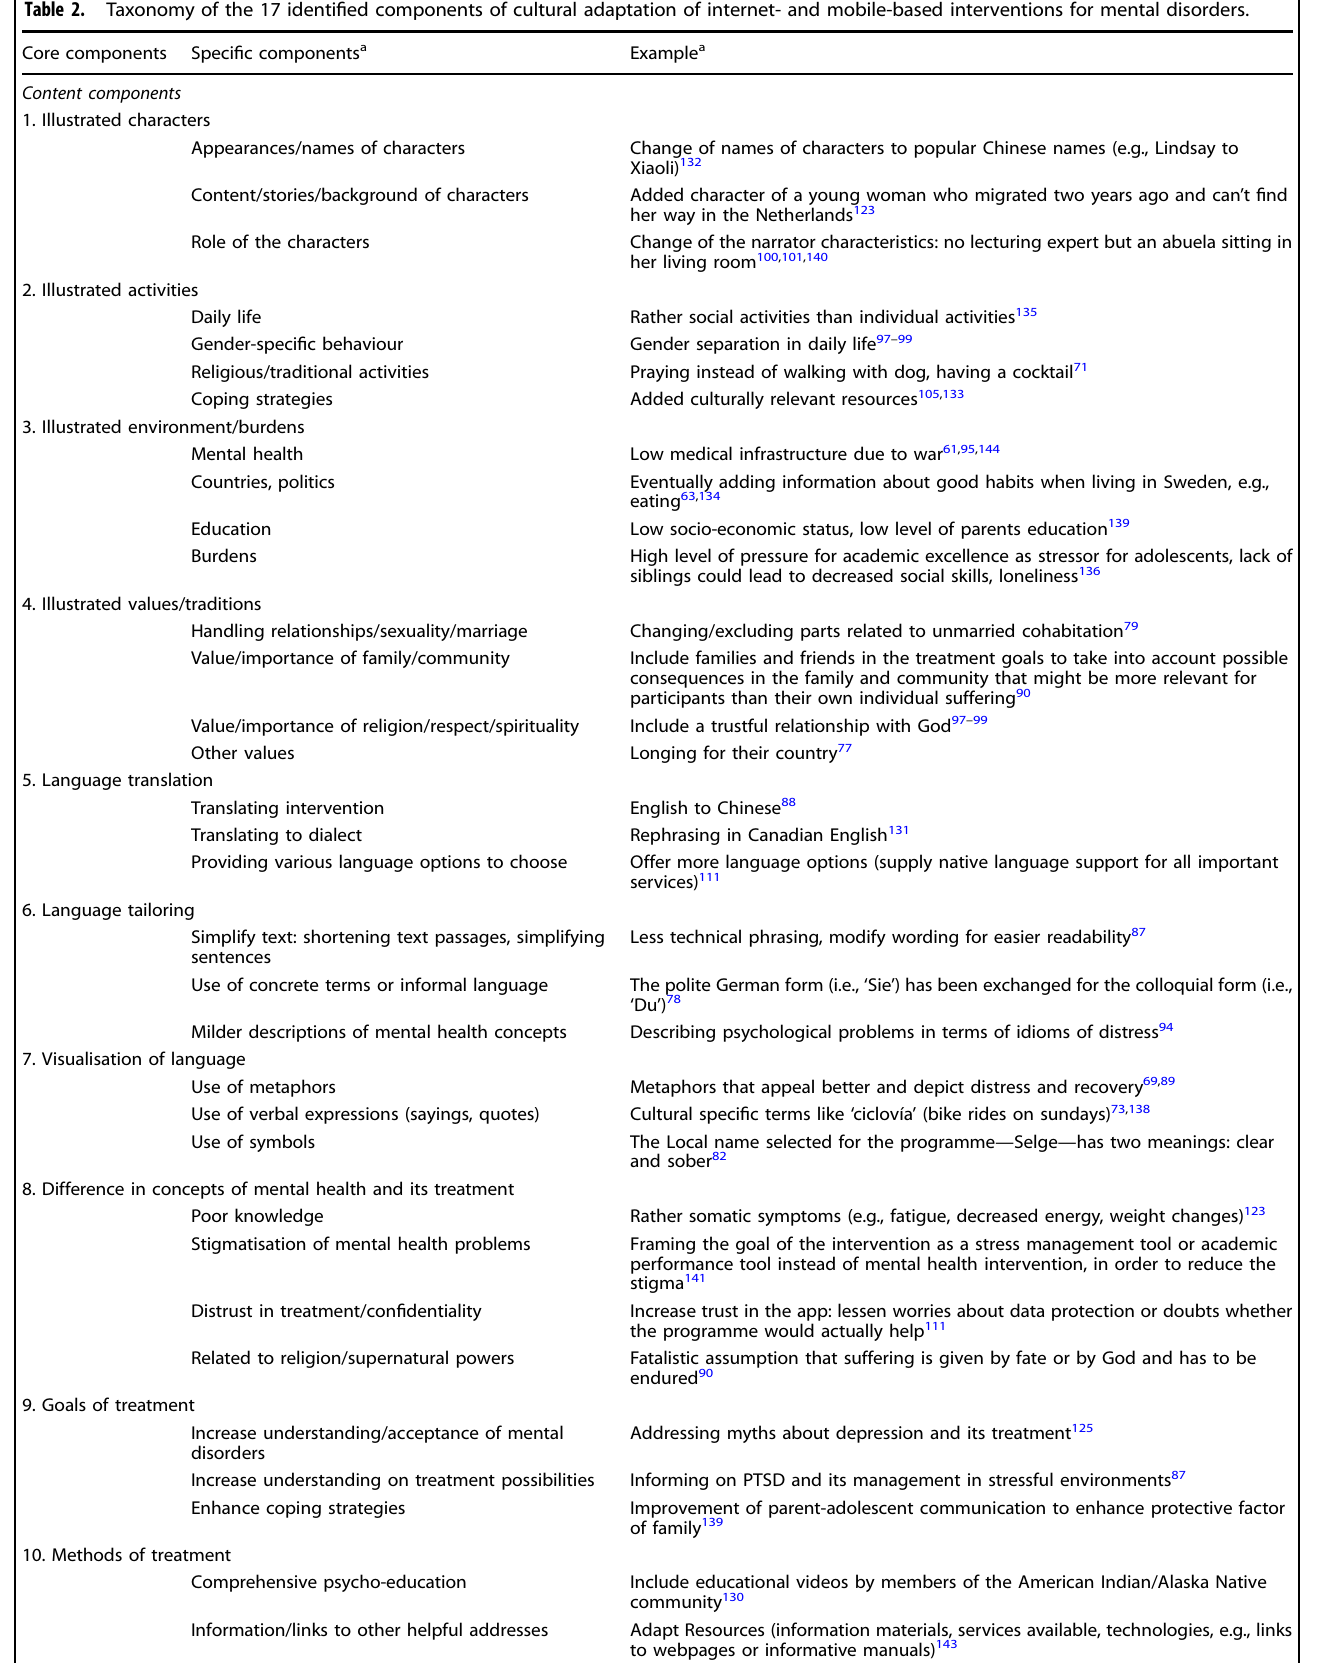
Table 2. Taxonomy of the 17 identi fi ed components of cultural adaptation of internet- and mobile-based interventions for mental